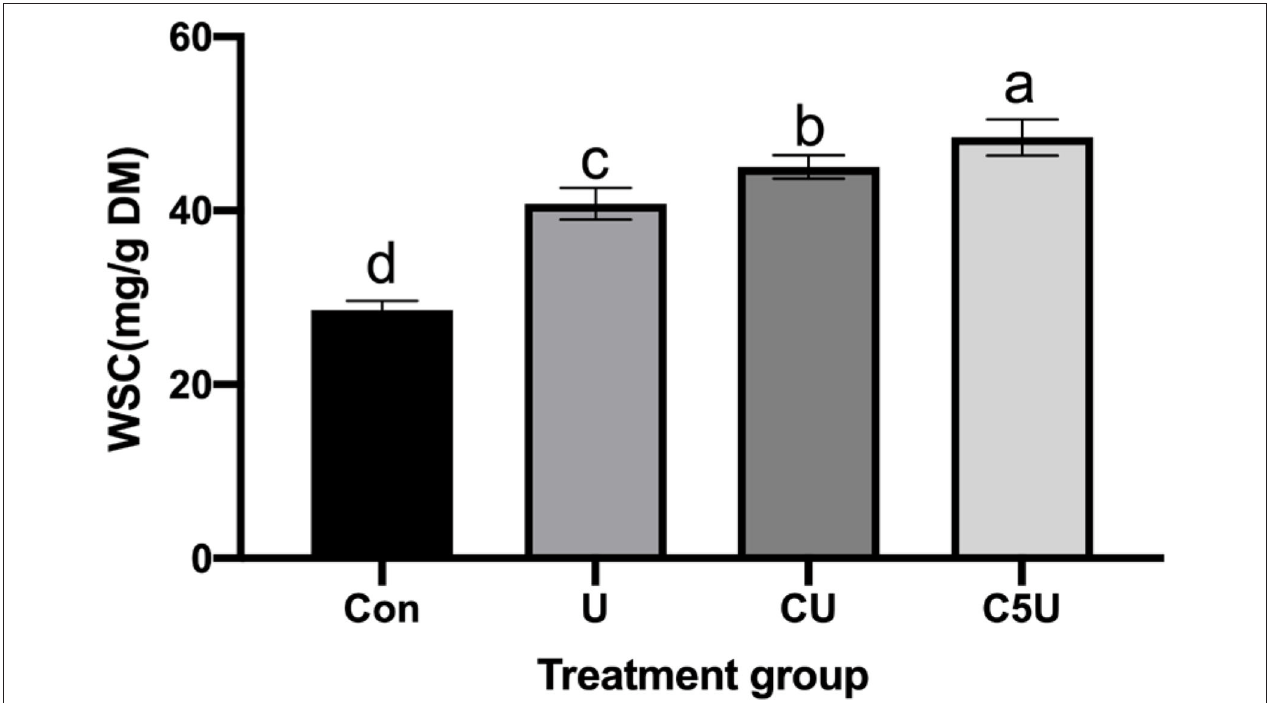
FIGURE 4 | Effect of CSL and urea pre-treatment on the enzymatic water soluble carbohydrate (WSC) yield of RS. Con, without additive control; U, 5% urea; CU, 9% CSL + 2.5% urea; C5U, 9% CSL + 5% urea. Different superscript letters a, b, c, and d indicate significantly different values ( P < 0.05) in different groups, and the same or no letters indicate insignificant differences ( P > 0.05).